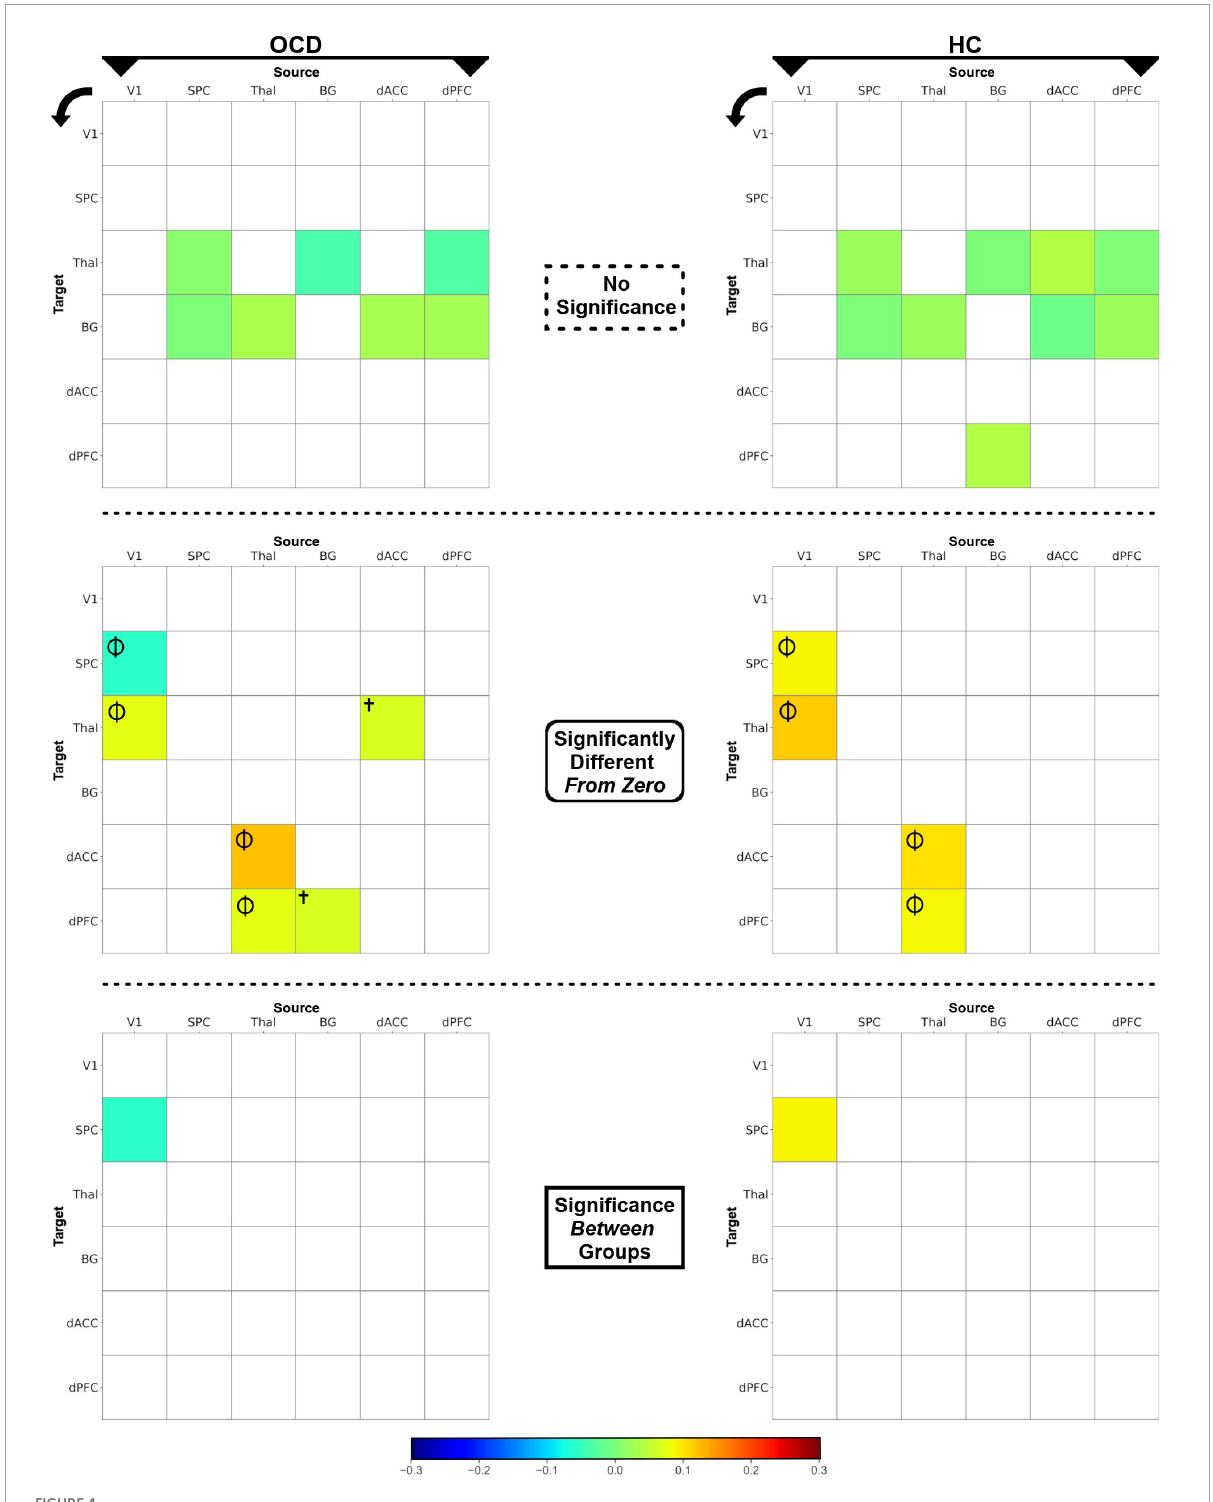
FIGURE4 The heat maps depict posterior intrinsic connectivity means for OCD (left) and HC (right) groups. The posterior means are displayed using a blue-to-red color bar and the maps are divided by the nature of the effects (non-significant, different from zero, different between groups. (Top row) Non-significant posterior means are depicted for each of the OCD (left) and HC (right) groups. (Middle row) Posterior means which were significantly different from zero ( p < 0.05, one-sample t -tests, i.e., there was significant intrinsic connectivity) are depicted. Effects observed in both groups ( (cid:56) ) or only in OCD ( † ) are marked. (Bottom row) The intrinsic connectivity of the V1 → SPC pathway was significantly reduced in OCD, revealed in an independent-samples t